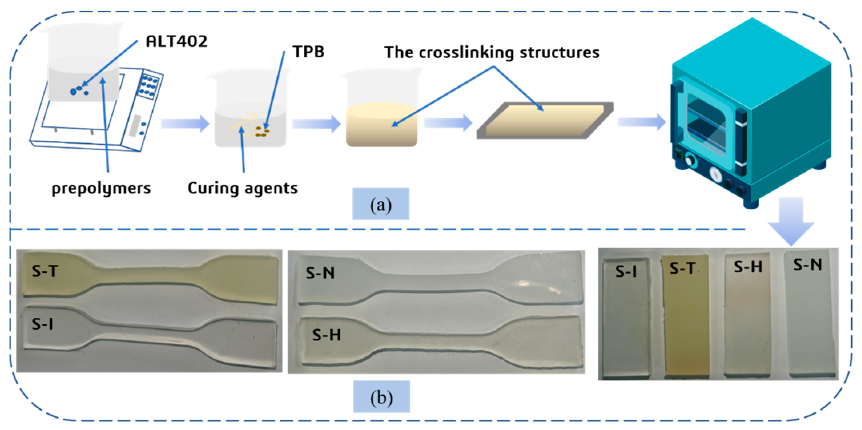
Figure 3. ( a ) the diagram illustration of the preparation process of INP binders; ( b ) the uniaxial tensile and DMA specimens of IPN binders.